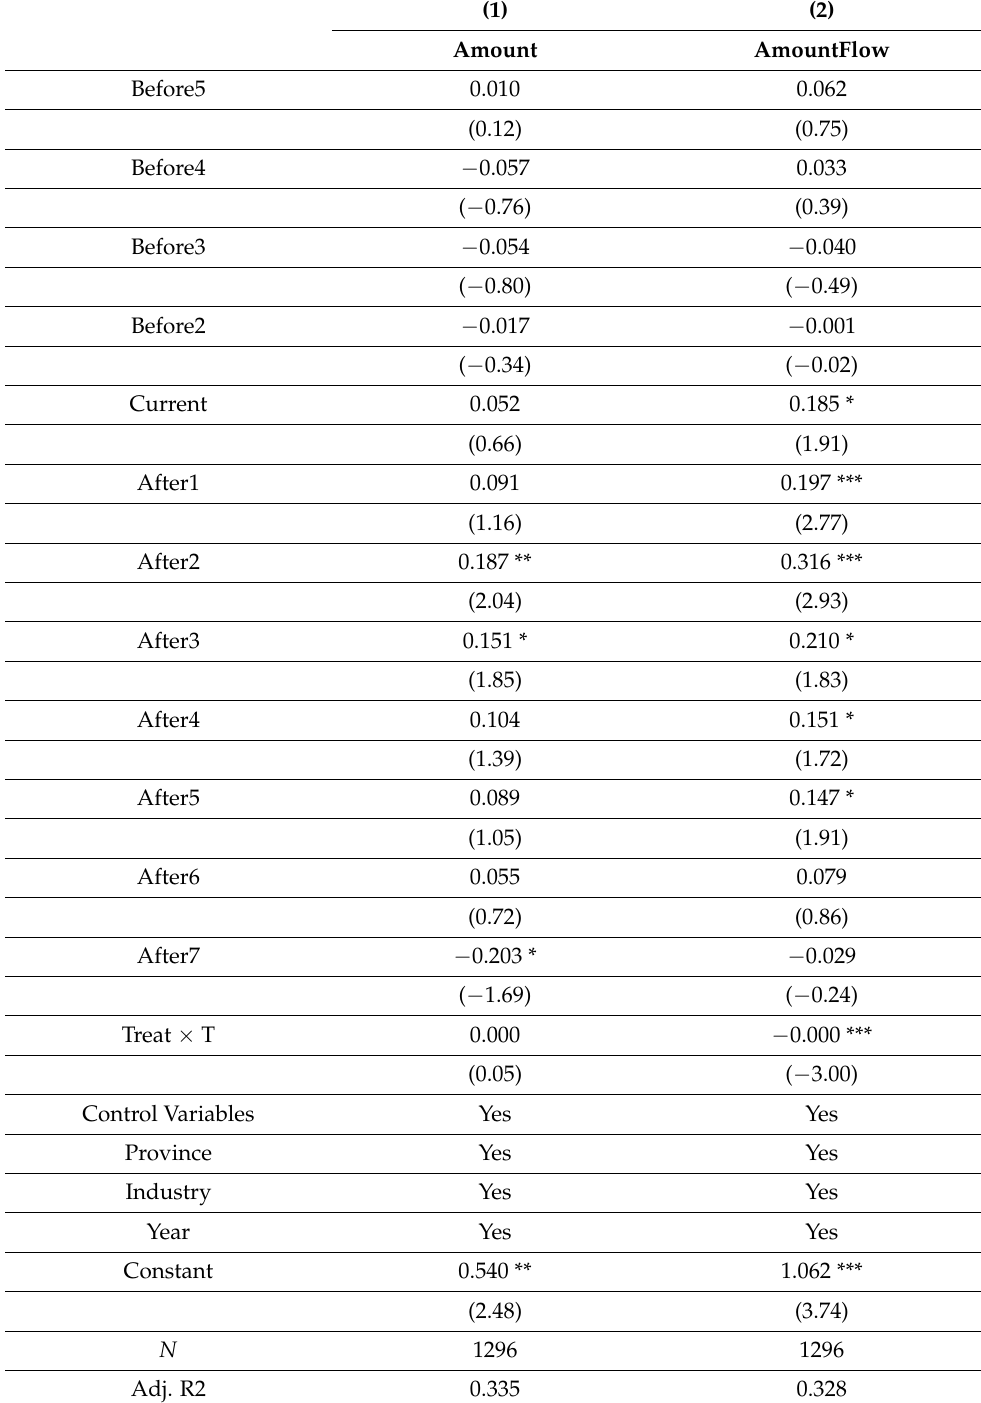
Table 4. Regression results of parallel